Question: Express in one sentence what the figure is showing.
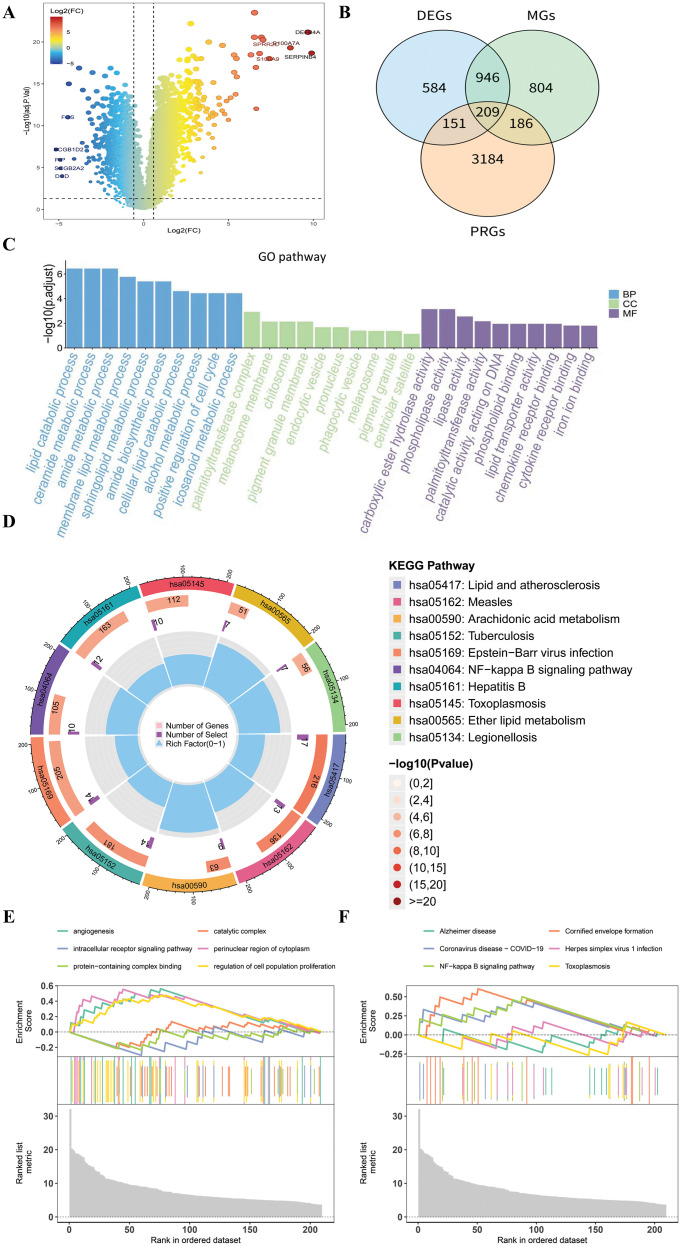
Answer: Identification of palmitoylation-associated differentially expressed genes. (A) Volcano plot of psoriasis versus control DEGs in GSE14905 . (B) Venn diagram showing the intersection among upregulated DEGs, disease-associated module genes, and palmitoylation-related genes. (C) GO enrichment analysis of Palm-DEGs. (D) KEGG enrichment analysis of Palm-DEGs. (E) GO-based GSEA results. (F) KEGG-based GSEA results.